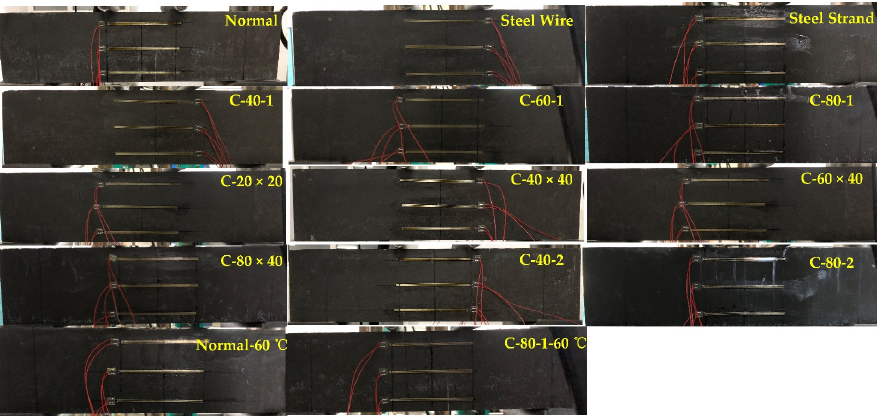
Figure 7. Prepared specimens.